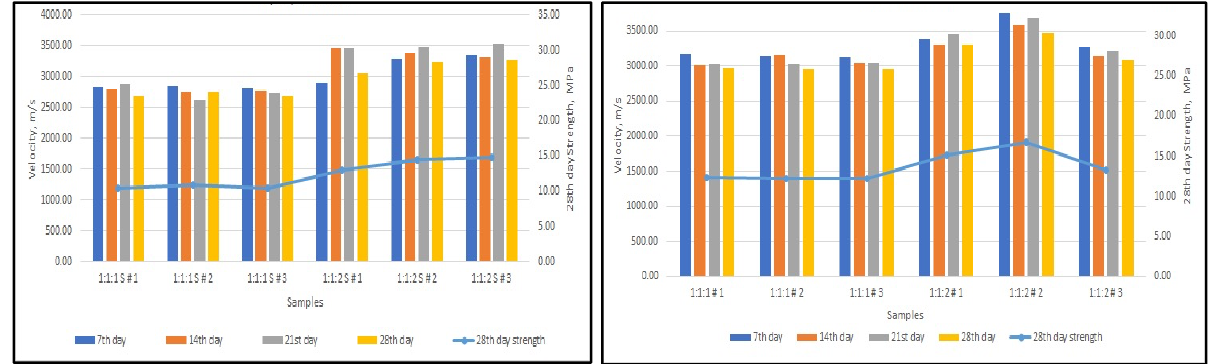
Table 3. Assessment of the Workability of the Geopolymer Samples.